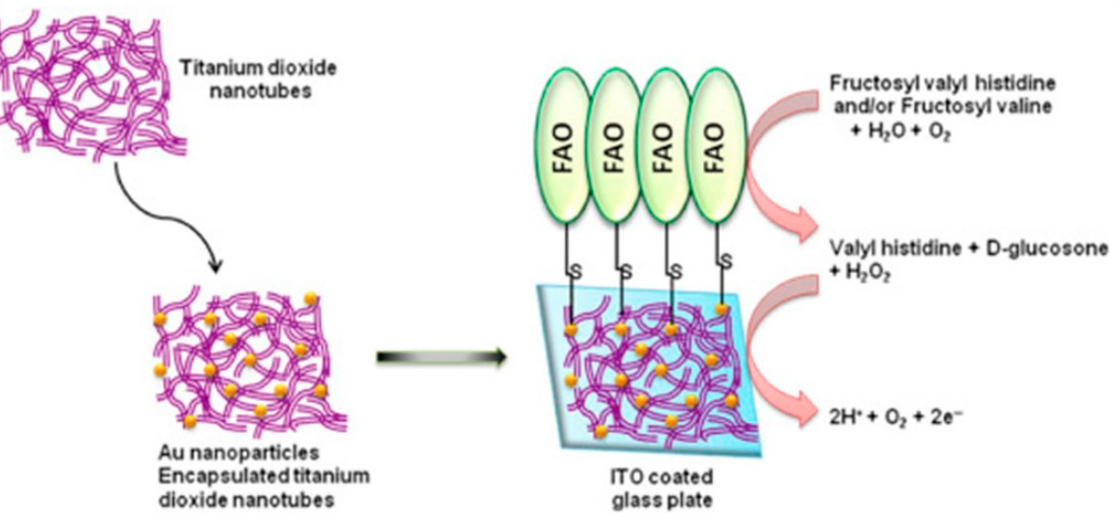
Figure 7. The final working electrode, FAO/AuNPs-PTA-TiO 2 /ITO, employed for quantification of FV. Reprinted with permission from [75].